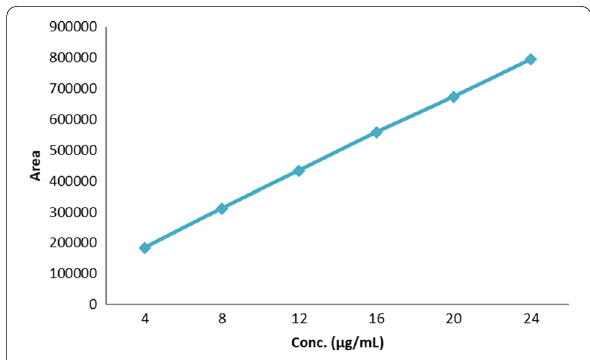
Fig. 3 Calibration curve of Mupirocin calcium. Y 30420x 66435Slope = + Coefficient =